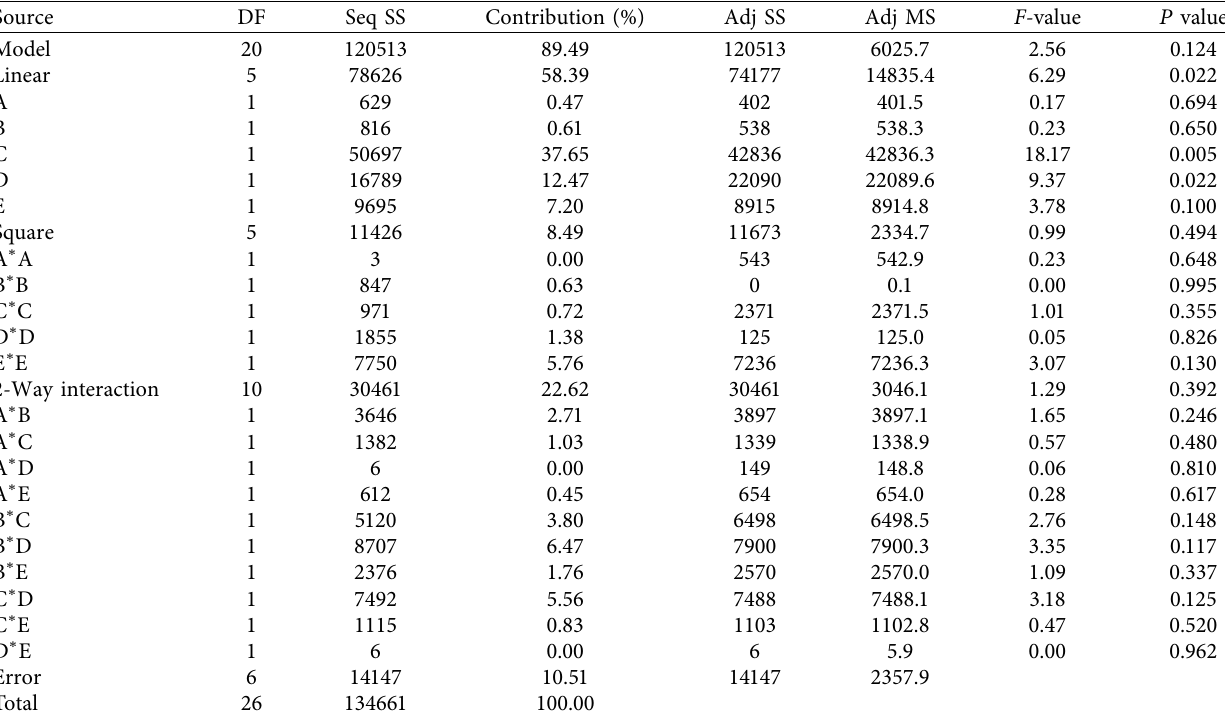
Table 6: Analysis of variance for the